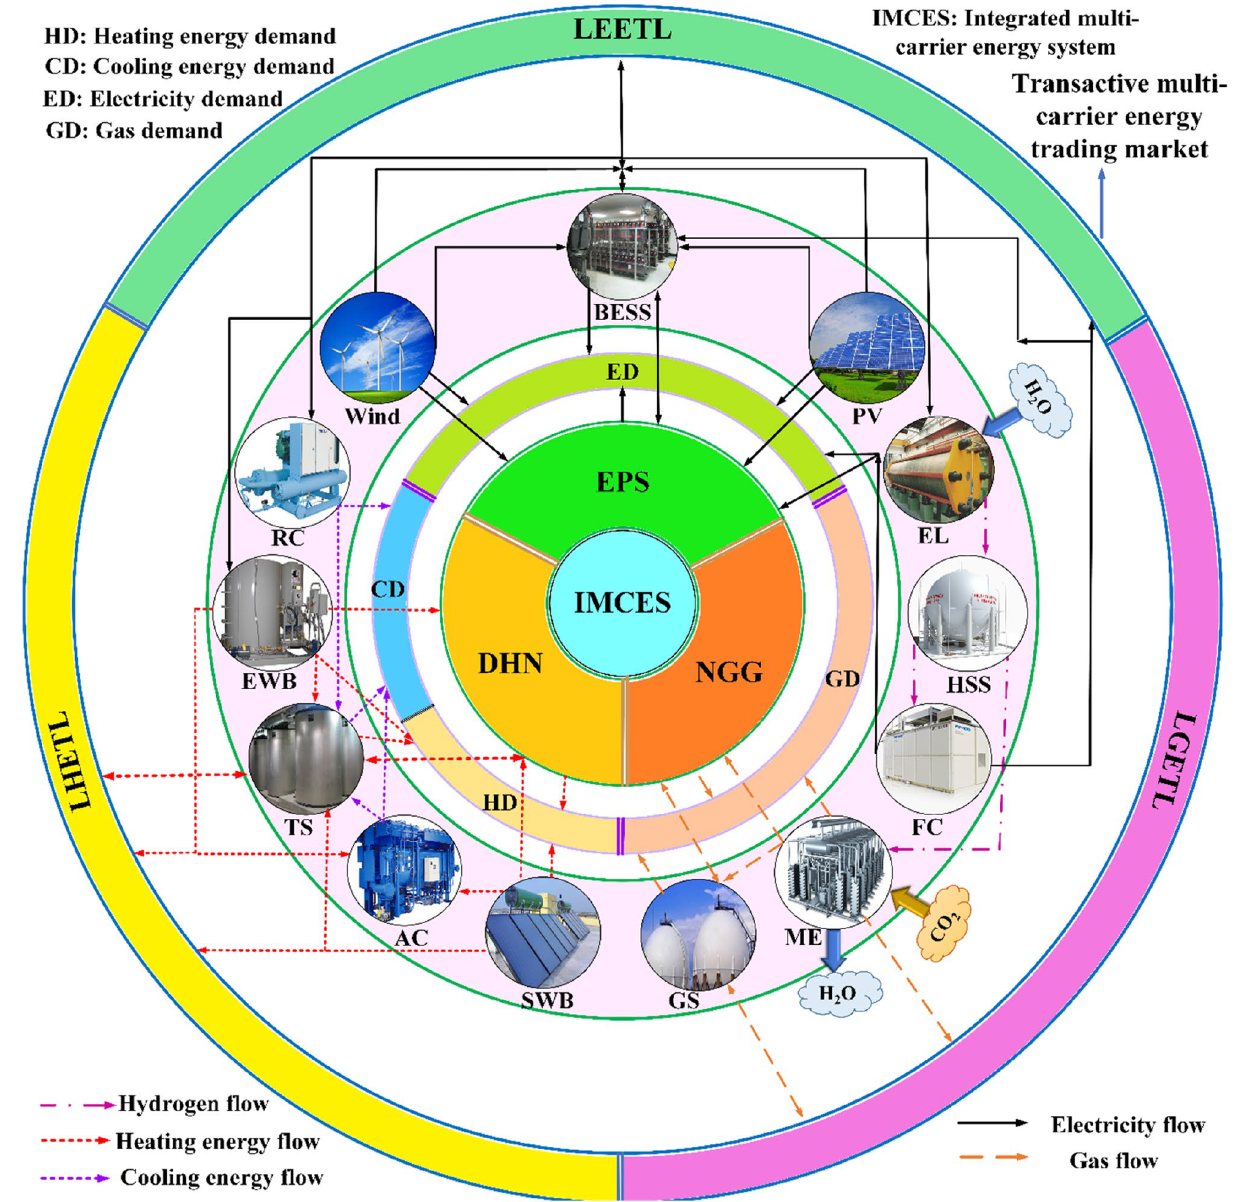
multi-energy interactions that models energy dependences among various energy